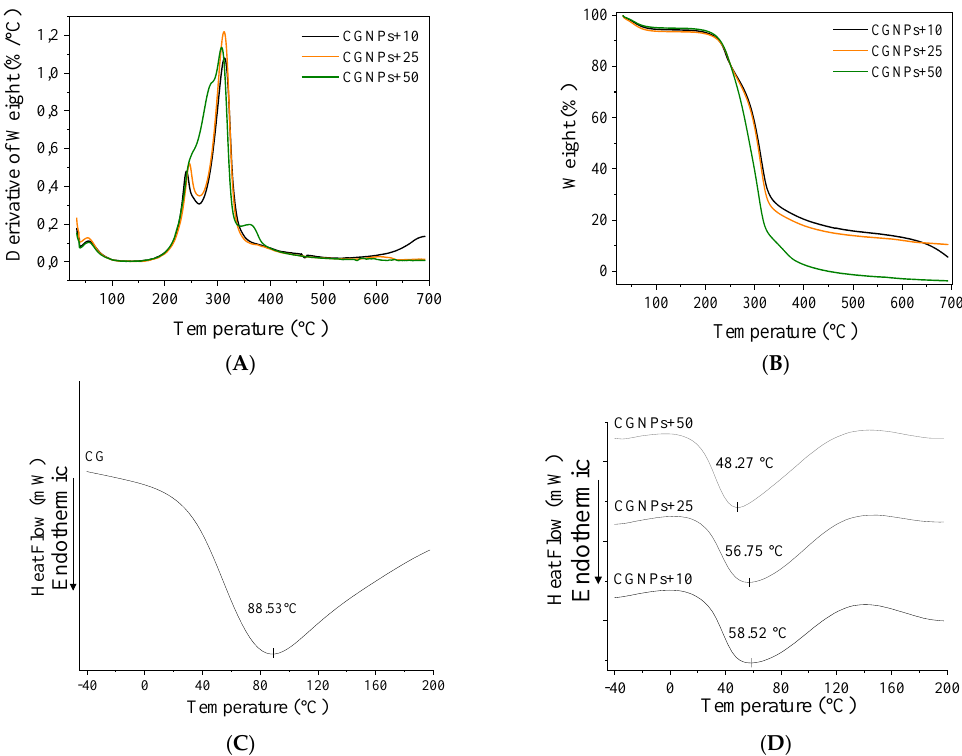
Figure 4. ( A ) TGA/DTG curve of the CG particles with different concentrations of α -tocopherol obtained under dynamic nitrogen atmosphere (50 mL·min −1 ), β =10 °C·s −1 , and m= 2.5 ± 0.5 mg; ( B ) DSC curves of CG and CGNPs with different concentrations of α -tocopherol; Where: CGNPs+50 = cashew gum nanoparticle with 50% of α -Tocopherol; CGNPs+25 = cashew gum nanoparticle with 25% of α -Tocopherol; CGNPs+10 = cashew gum nanoparticle with 10% of α -Tocopherol.